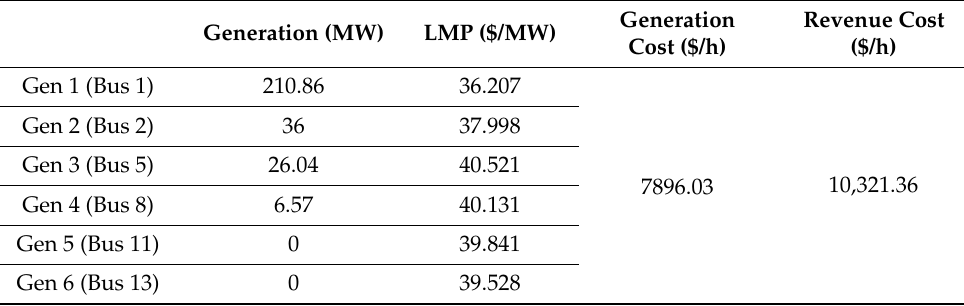
Table 4. Revenue and generating costs with a double auction bidding without